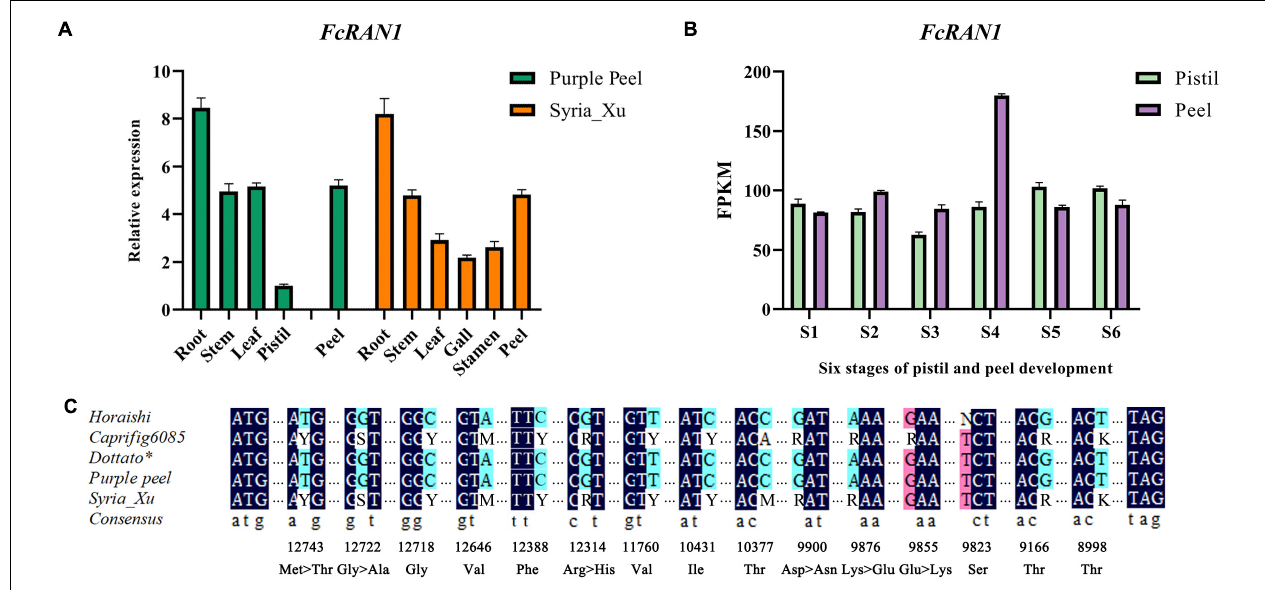
FIGURE 5 | Expression analysis of FcRAN1 and its SNPs. (A) Results of qRT-PCR for FcRAN1 expression in different tissues of “Purple Peel” (female) and “Syria_Xu” (male) fig trees. (B) FcRAN1 in the transcriptome data of “Purple Peel” fruit. (C) Preliminary verification of 15 SNP sites, of which sites seq000259_10377,